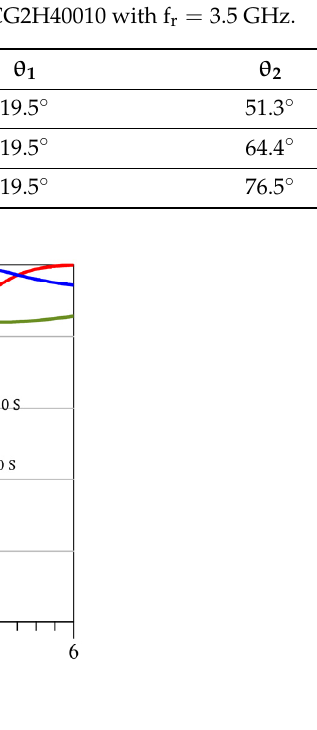
Figure 2. | Γ int | for different values of Y 02 using the CG2H40010 device. With the values of Y 01 and Y 02 , using (6)–(11), | Γ int | can also be studied for different values of f r . This is shown in Figure 3 for both devices. In Table 4, the obtained values of θ 1 and θ 2 versus f r are presented.